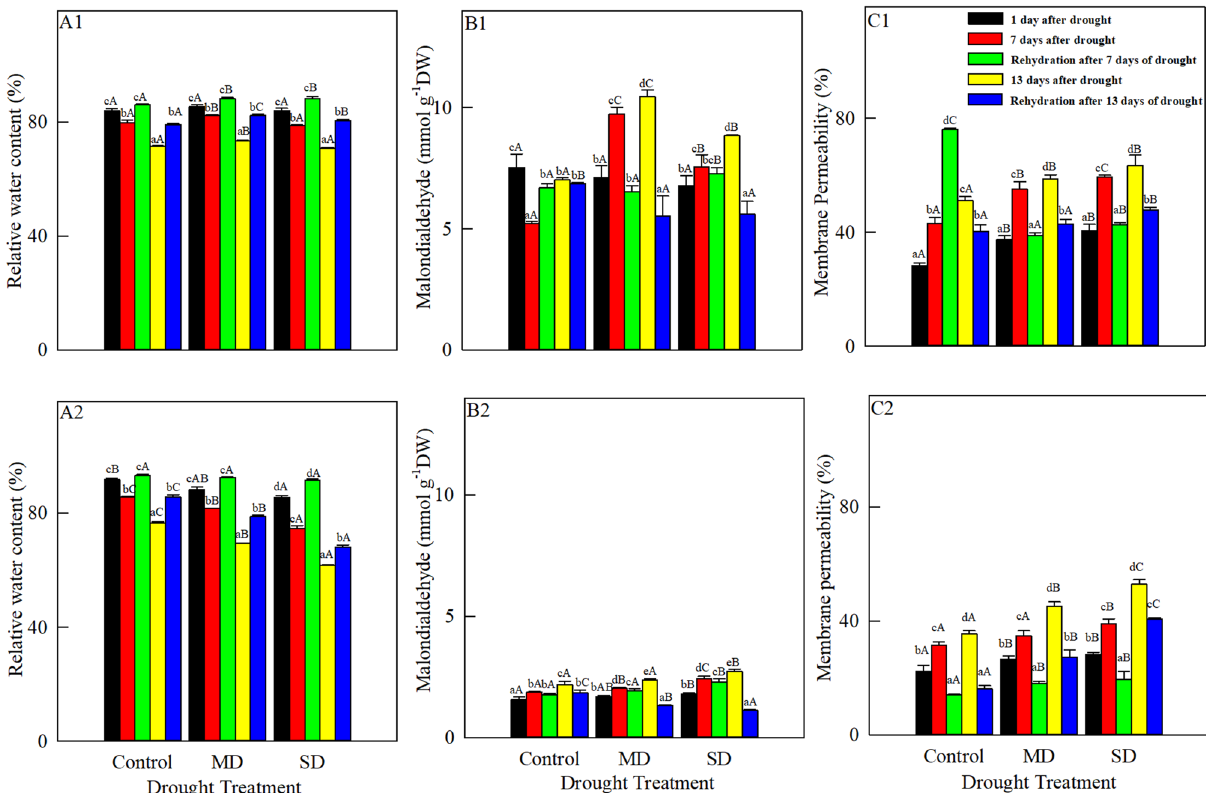
Figure 2. Changes in RWC, malondialdehyde and membrane permeability of A. squarrosum ( A1 , B1 , C1 ) and S. viridis ( A2 , B2 , C2 ) under drought stress (August 1, 7, 13) and rehydration (August 8, 14). Different lowercase letters indicate significant differences among days for the same treatment. Different capital letters indicate significant differences among drought treatments for the same